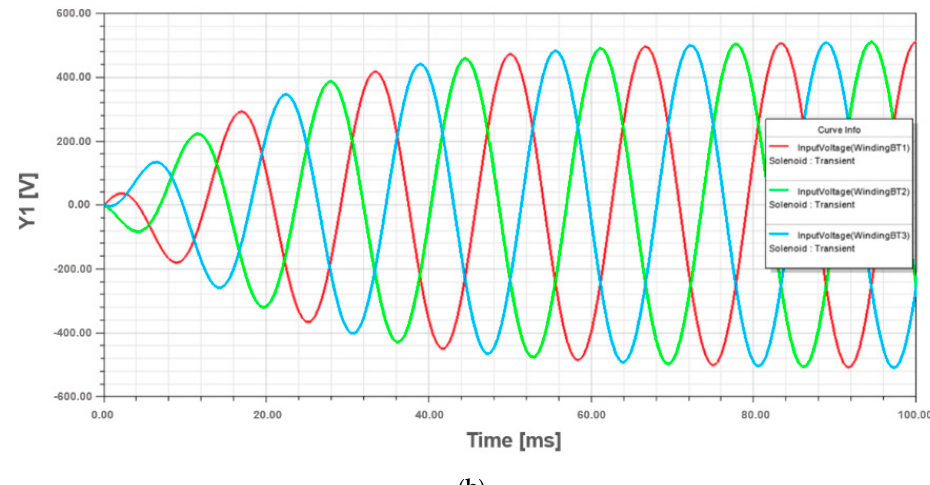
Figure 5. Winding voltage waveforms of the standard design transformer: ( a ) HV winding; ( b ) LV winding.